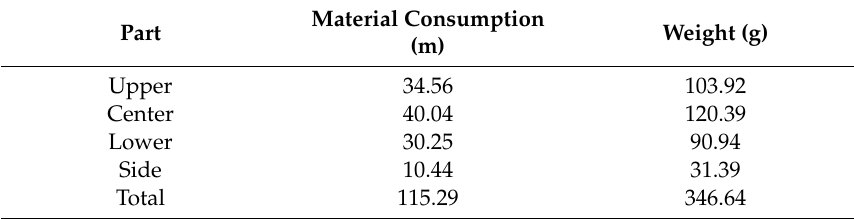
Table 4. Materials consumption of additive manufacturing.